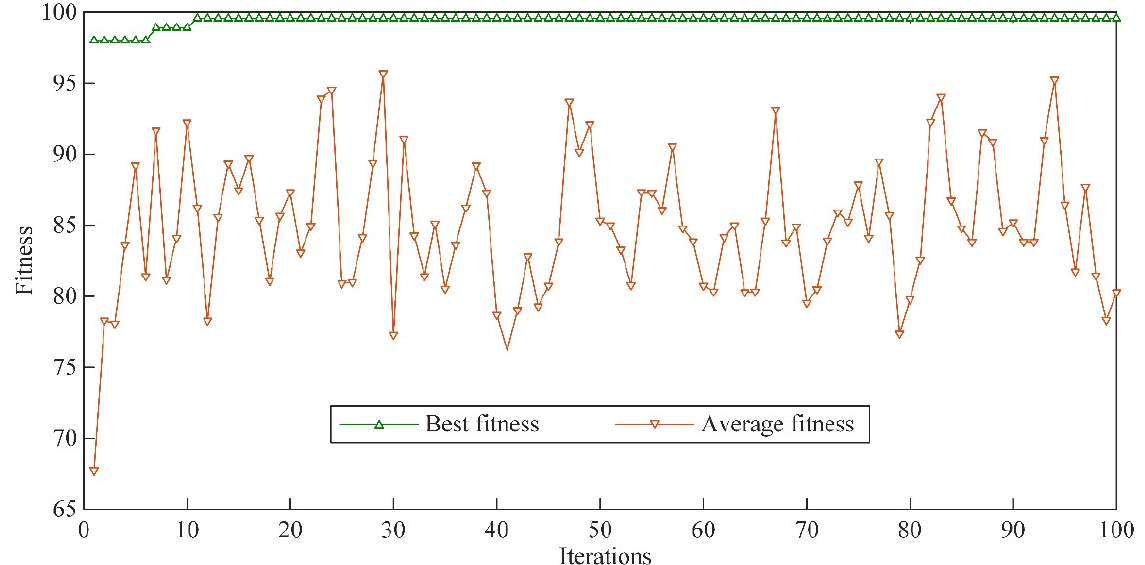
Figure 9. Fitness curve of SVM training process.